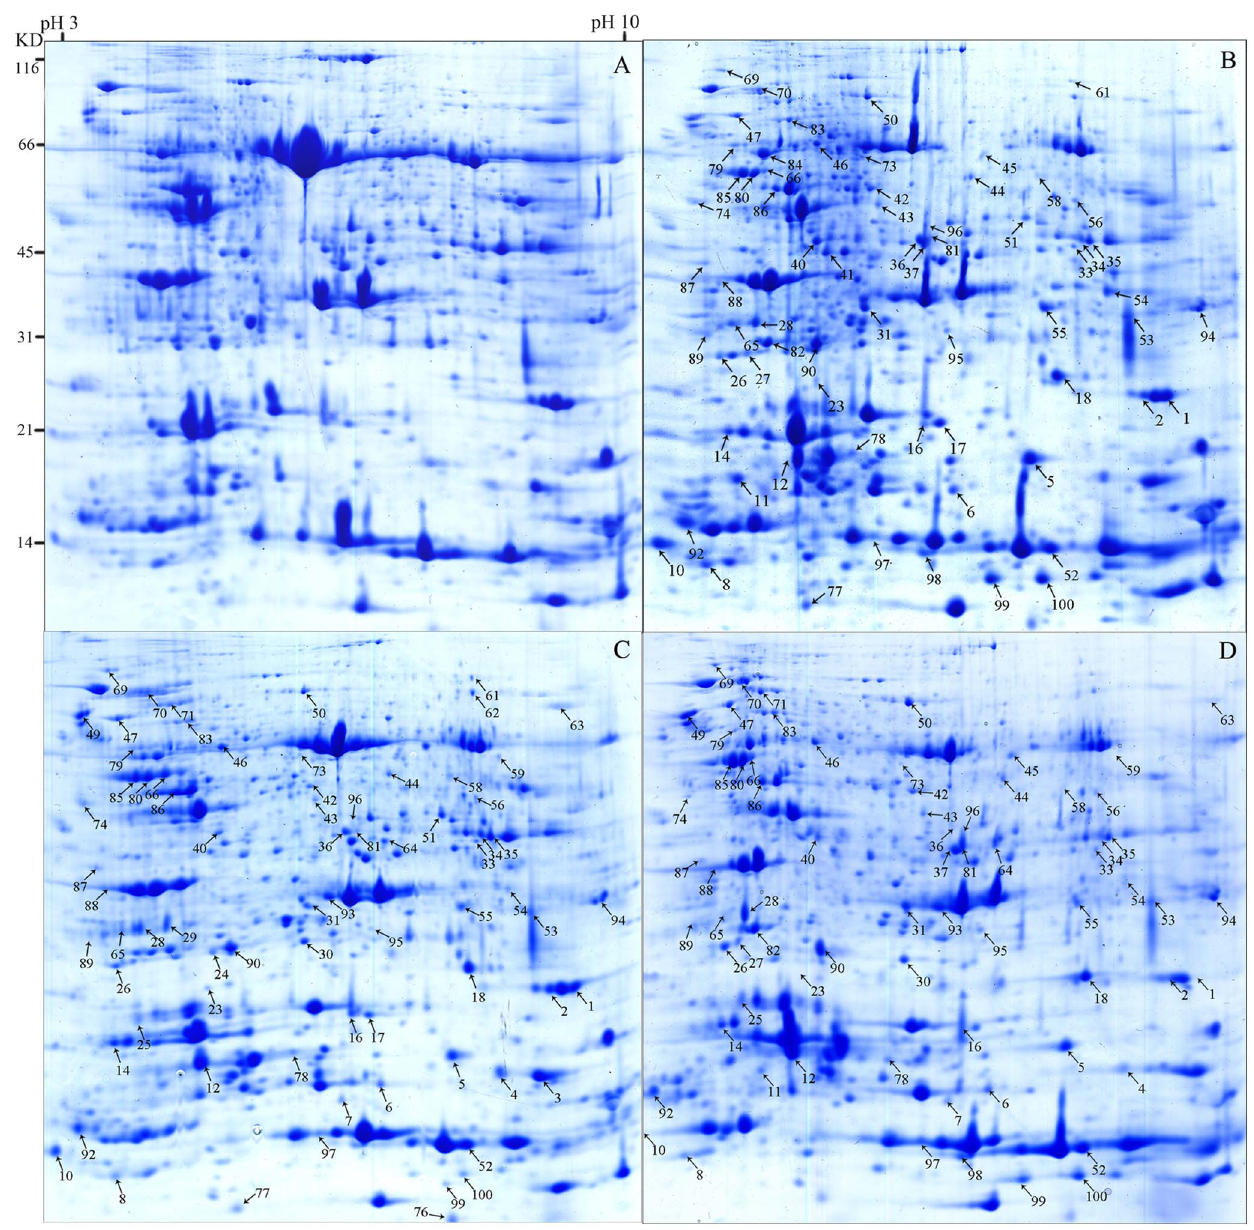
Figure 2. 2-DE analysis of alfalfa leaf proteins extracted from alfalfa leaves grown under control(A), heat stress (40 6 C for 24(B), 48(C) and 72 h(D)) samples. A total of 600 m g proteins were separated by 2-DE as described in the material and methods and then visualized using CBB stain. Arrows indicate proteins that were 1.5 fold changes in respond to heat stress.